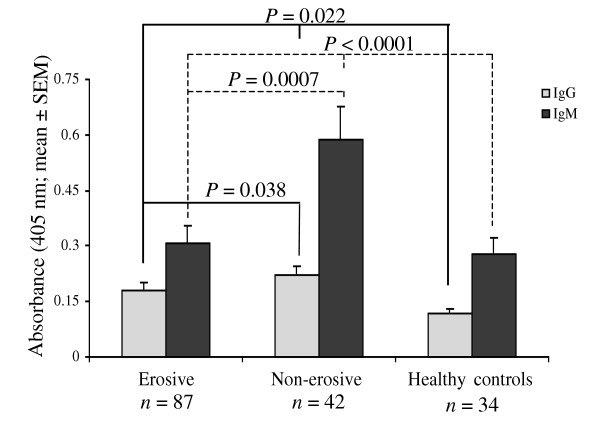
Synovial fluid antibodies of both IgG and IgM isotypes specific for survivin are higher in rheumatoid arthritis patients with the non-erosive course compared with the erosive course of the joint disease. SEM, standard error of the mean.